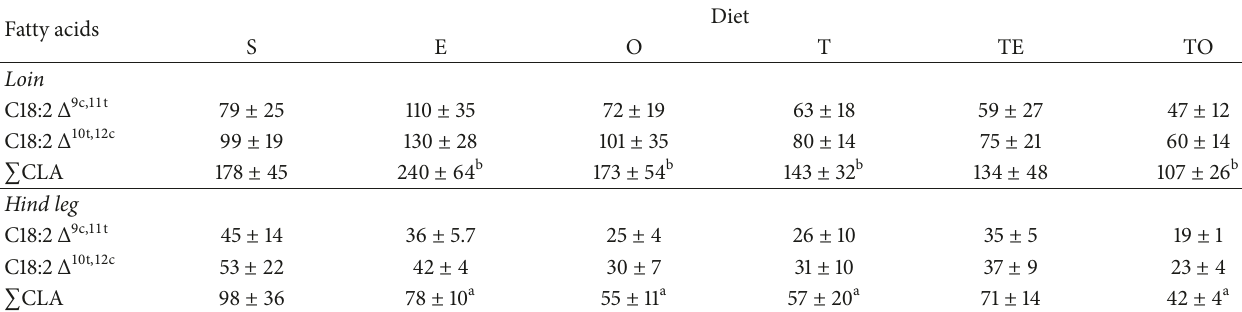
Table 7: Conjugated linoleic acid isomers content (mg/100 g meat) in rabbit loin and hind leg meat samples. Fatty